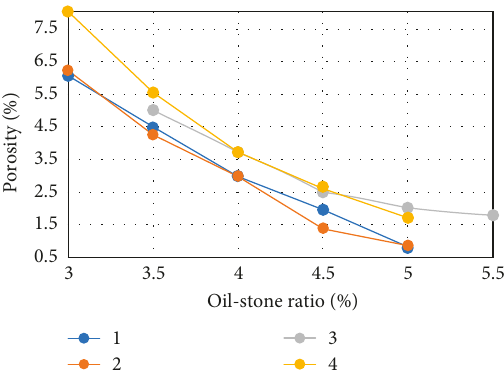
Figure 5: Relation between AC-16 shear safety factor and oil-stone ratio.